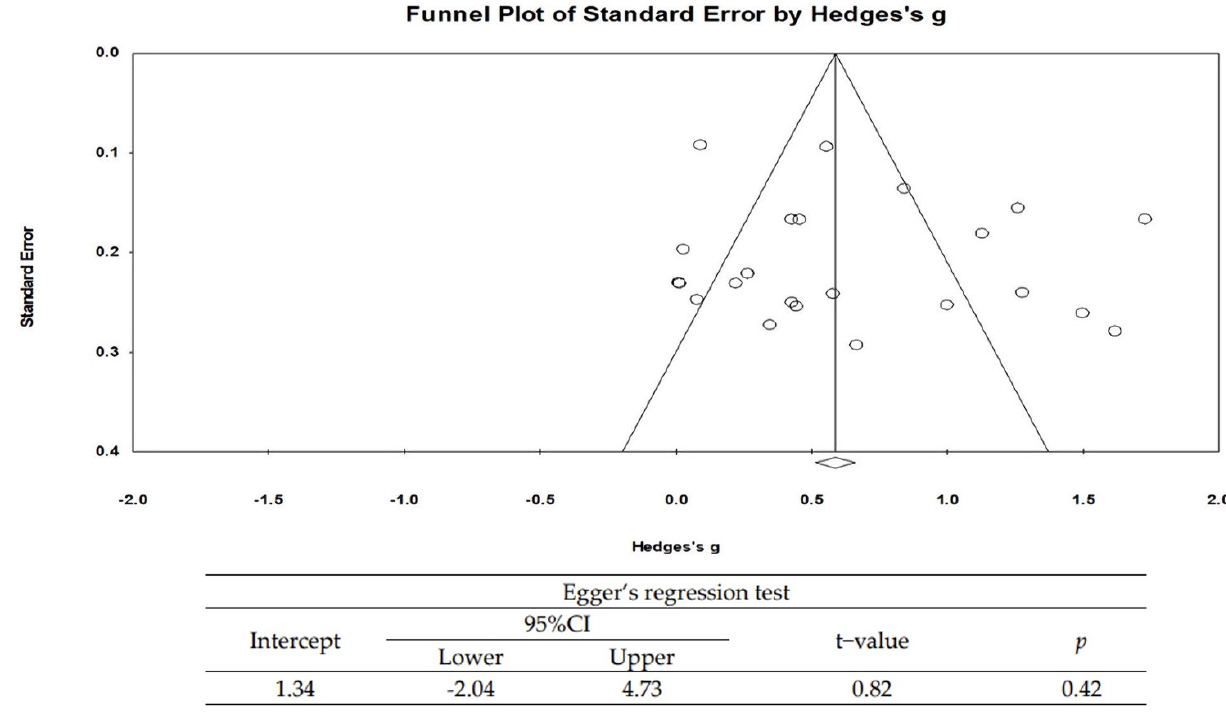
Figure 3. Publication bias.